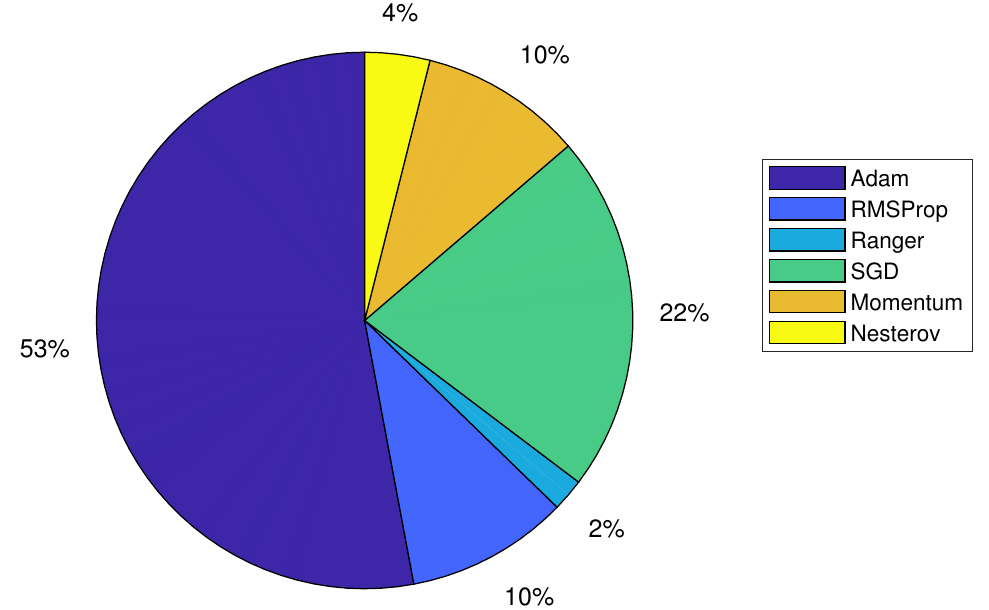
Figure 11. Distribution of different deep learning optimizer used in controlled environment